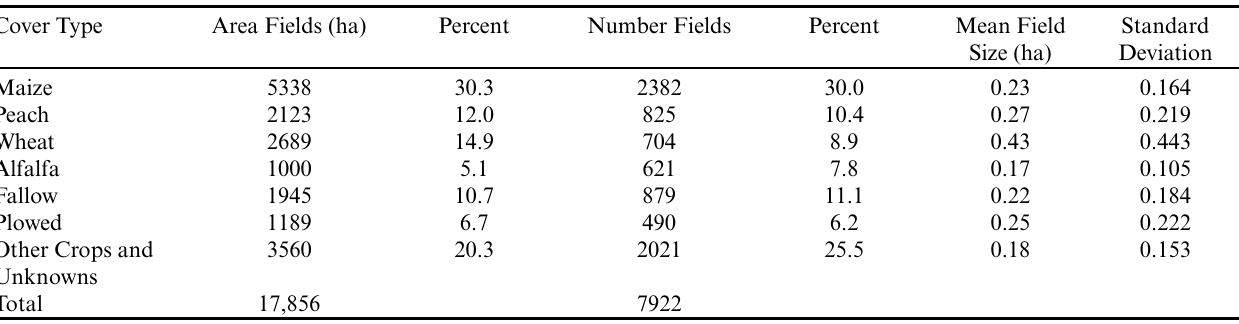
Table 3 . Estimated overall areas and the numbers and sizes of individual fields of the major types of cover in agriculture of the Tarata- Arbieto cultural landscape.